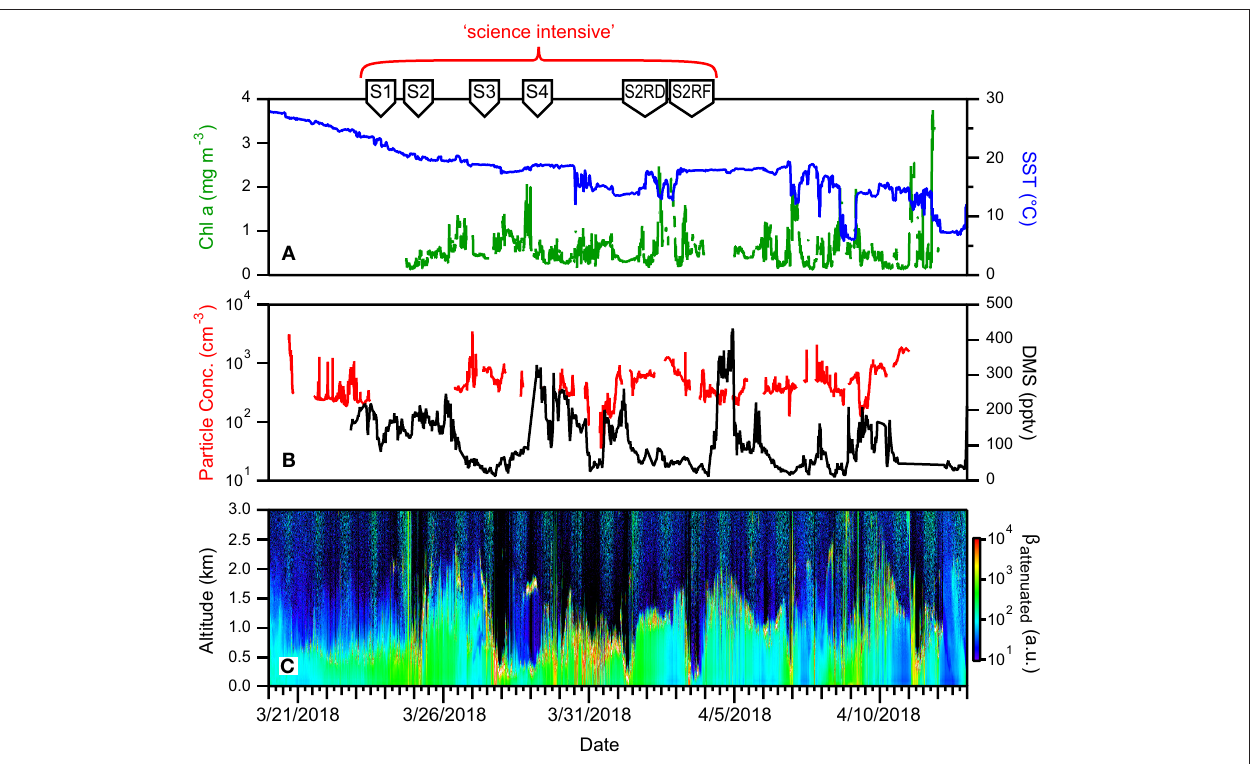
FIGURE 16 | Ocean and atmosphere properties as a function of campaign date during NAAMES 4. (A) Surface chlorophyll concentration (green line) and sea surface temperature (SST; blue line) as a function of hours along ship transit. (B) Particle number concentration (red line) and dimethylsulfide gas mixing ratio (black line) along the ship transit. (C) Attenuated backscatter curtain in arbitrary units as detected by the ship-based ceilometer along the ship transit. The record begins on 3/20/2018 at 32 ◦ 32 ′ N, 51 ◦ 43 ′ W on the outbound transit and ends on 4/13/2018 at 41 ◦ 31 ′ N, 70 ◦ 40 ′ W on the return transit. Red bracket = “science intensive” segment of transit. Labeled symbols at top of panel indicate ship location at the beginning of each primary station